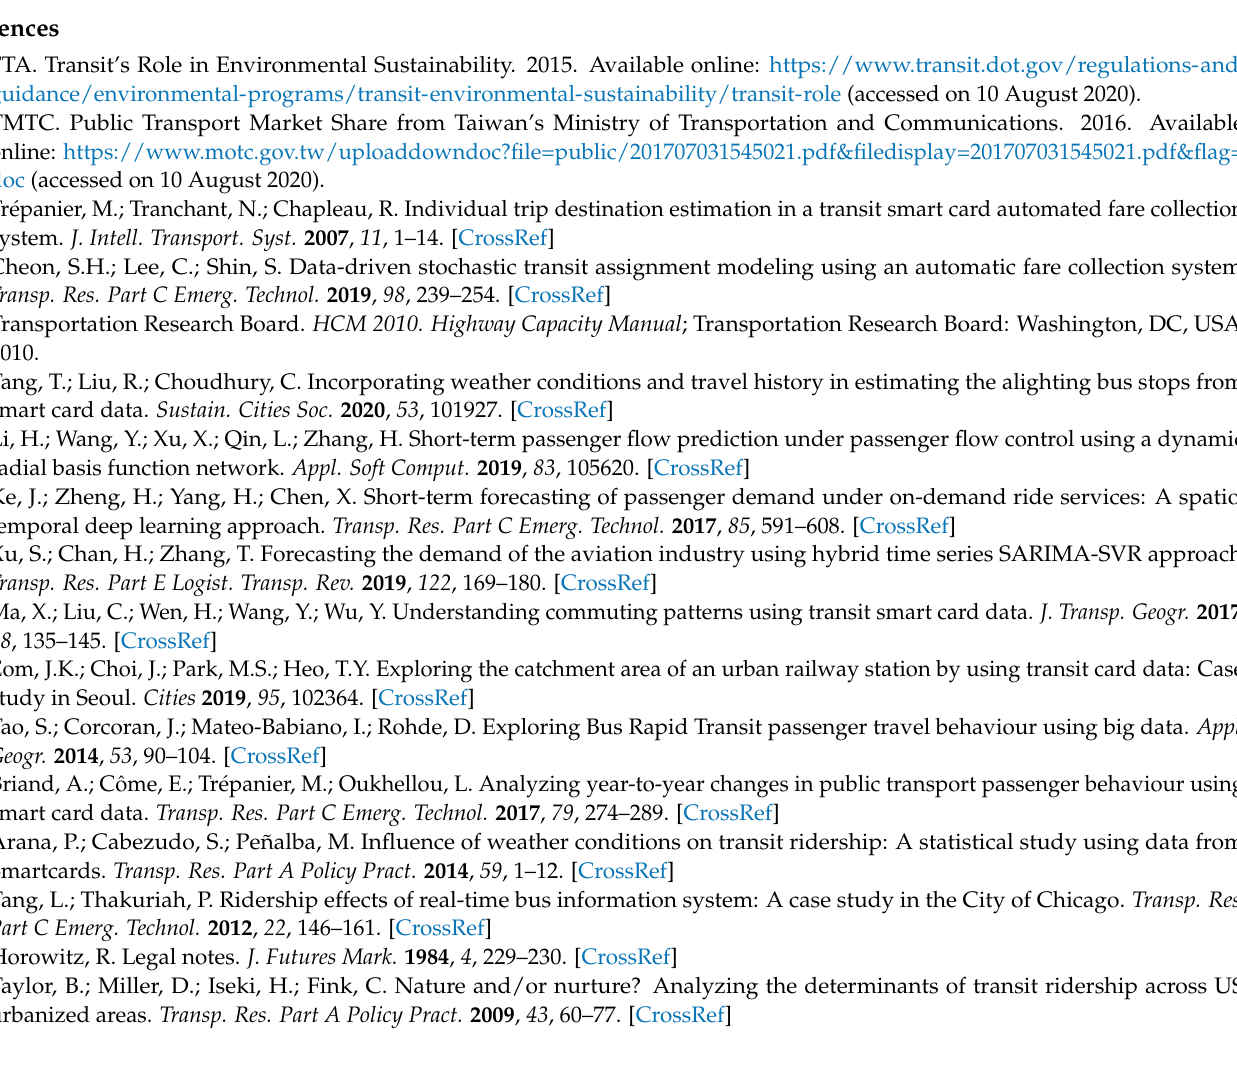
Table 10, the number of lags affected forecast results. Furthermore, most of the top three models are in the LSTM family, which presents a better